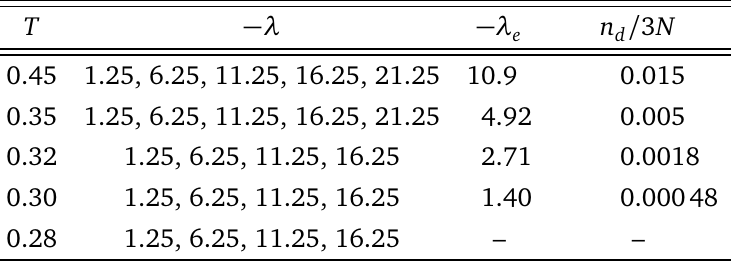
/ ( 3 N ) at all investigated temperatures d